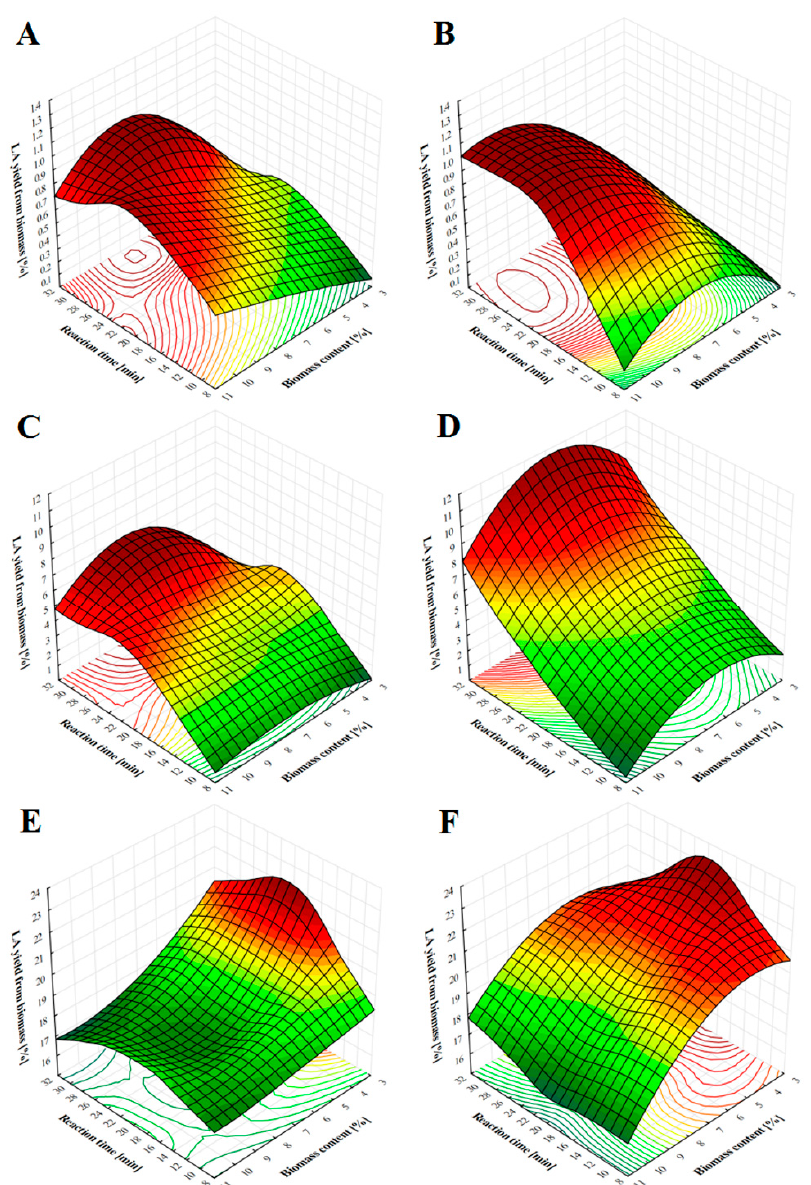
Figure 4. Response surface plot showing the effect of the interaction between biomass content of pine chips and reaction time of microwave-assisted conversion on yield of production of levulinic acid from biomass using nitric acid at a concentration of 1% ( A ) and 2% ( B ), phosphoric acid at a concentration of 1% ( C ) and 2% ( D ) and sulfuric acid at a concentration of 1% ( E ) and 2% ( F ).